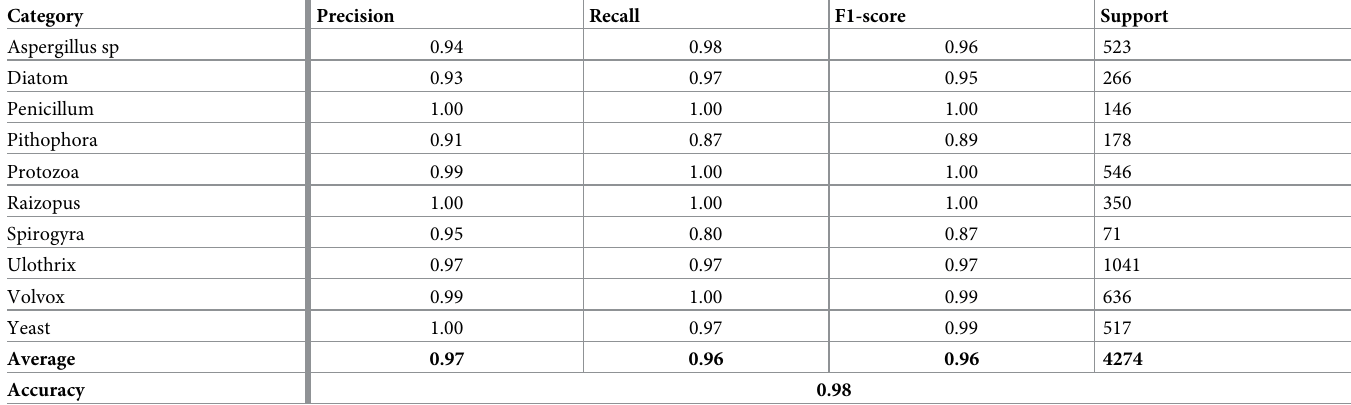
The pie chart-based error rate comparative analysis of employed learning techniques is visualized in Fig 8. The analysis demonstrates that the proposed approach has the minimum error rate indicating high-performance accuracy scores for the microbe organism predictions. Based on this analysis, the proposed approach has a 0.7% error rate. The high error rate of 22% is achieved by the LSTM model, which indicates the low accuracy scores. The analysis shows that DTC and RFC have the same error rate of 0.8%, indicating maximum accuracy scores. The classification report based on individual categories is given in Table 5. The analysis demonstrates that the organism’s categories Penicillum and Raizopus achieved a 100% score for all performance metrics. The categories Protozoa and Raizopus achieved 100% scores for recall and F1 score measures, respectively. The average performance metrics scores for all are Table 5. Individual class-vise report of the proposed